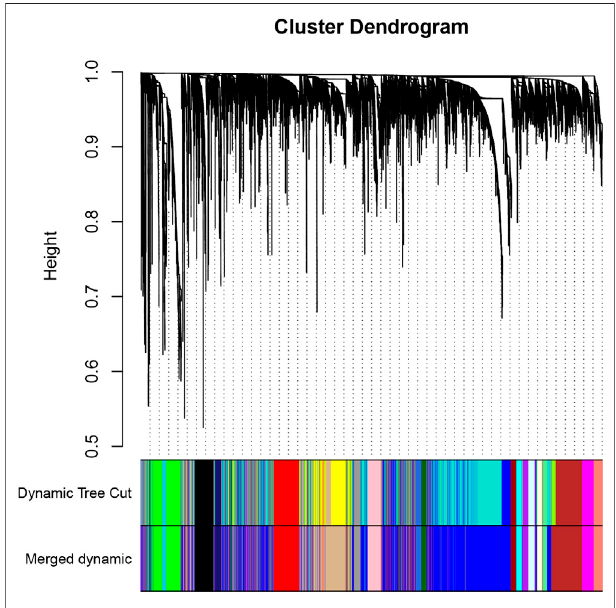
FIGURE 3 | The cluster dendrogram of module eigengenes.